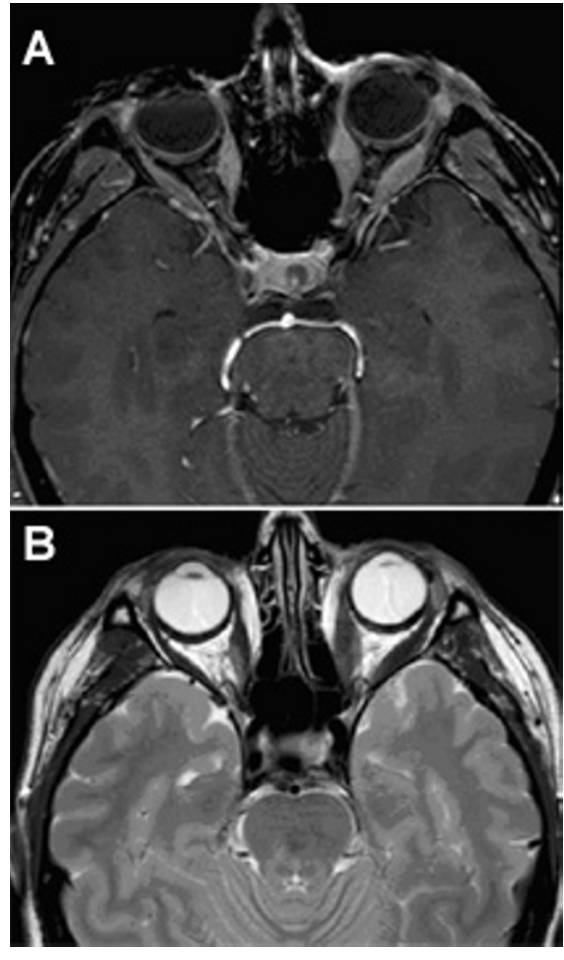
Figure 2. MRI (Philips 1,5T Akieva System) of case 3. (A) T1 weighted Fast Field Echo (FFE) axial images (TR 25, TE 4,6) showing swelling and enhancement with Gd- DTPA of both medial and left lateral recta. (B) Axial T2 weighted Turbo Spin Echo (TSE) sequences (TR 3000, TE 80) showing fusiform enlargement of both medial and left lateral recta. Table 1. Clinical features of the four present cases with idiopathic orbital myositis